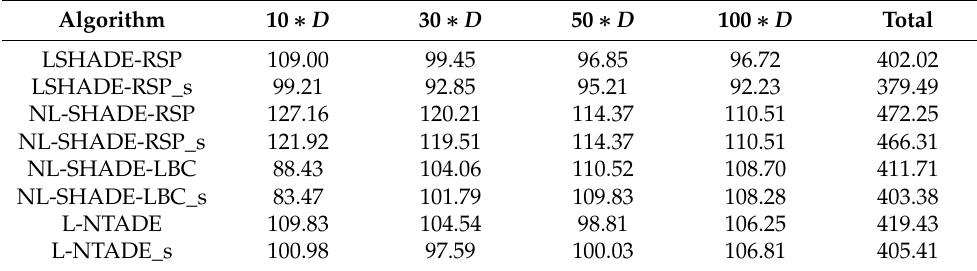
Table 2. Algorithms with and without crossover rate sorting, CEC 2017, and Friedman